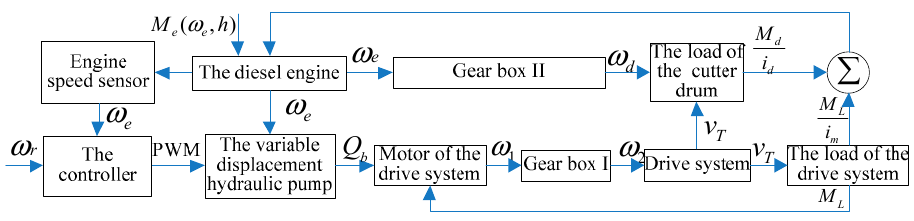
Figure 3. The diagram of the power control process.